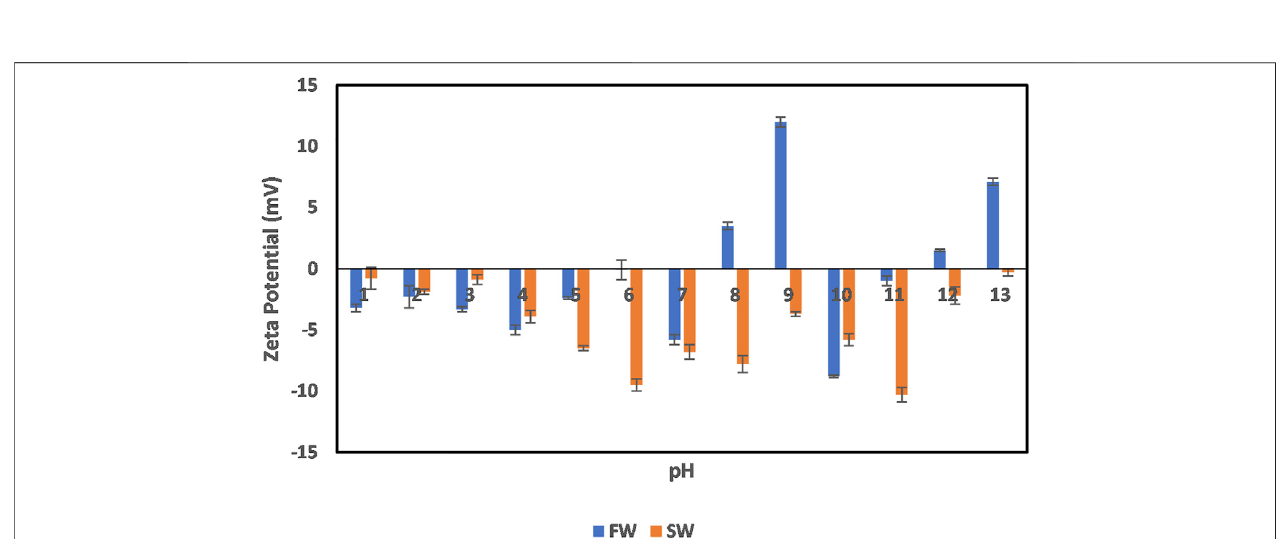
FIGURE 6 | Effect of oil fi eld operation on dolomite particle surface charge.